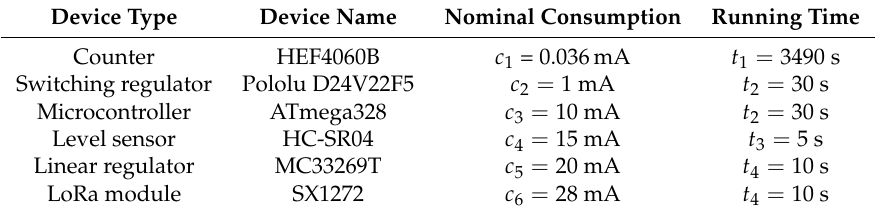
Table 2. Nominal consumption of the devices composing the node and their relative running time within T m . Device